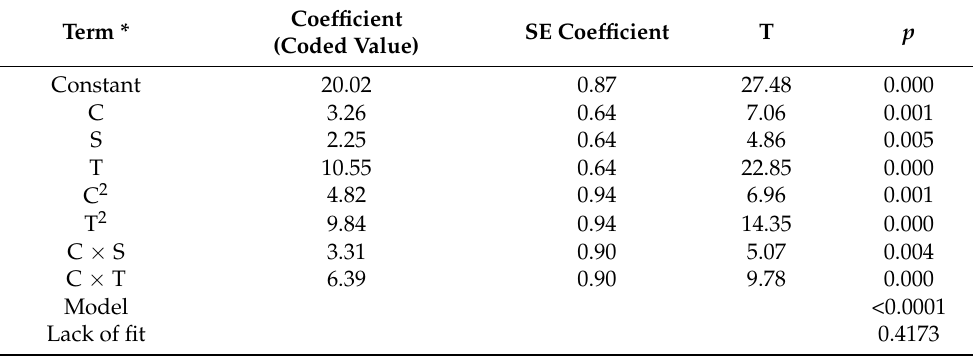
Table 4. Estimated regression coefficients for cellulose (%) response.